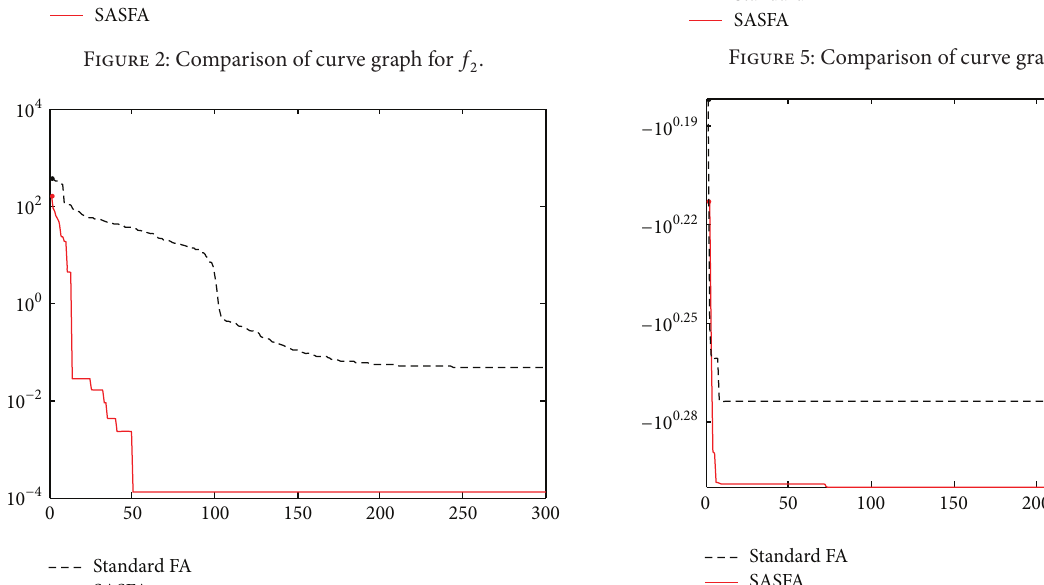
Figure 6: Comparison of curve graph for 𝑓 6